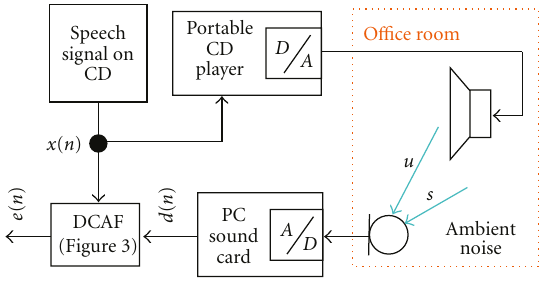
Figure 8: A room recording